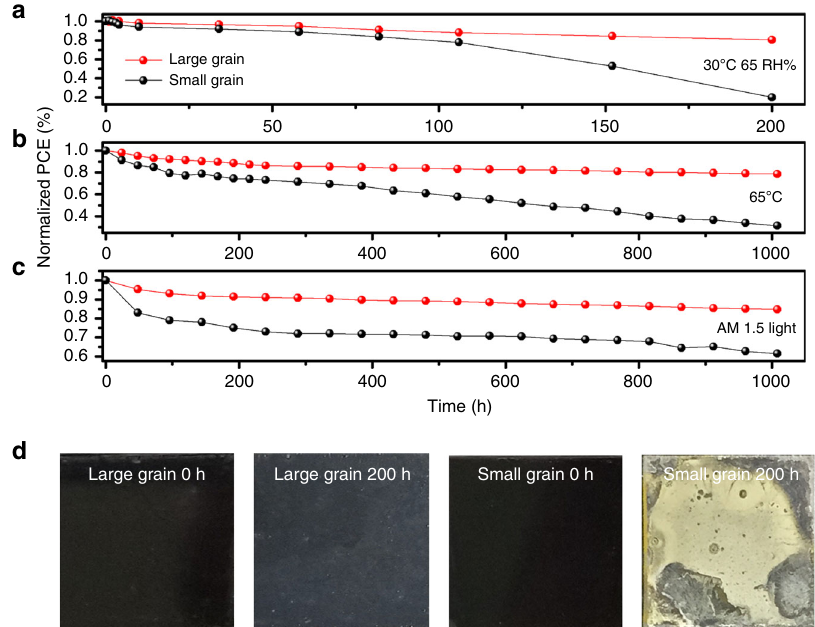
Fig. 5 Stability performance measurements. a – c Stability assessment of non-encapsulated perovskite solar cells with the large-grain and the small-grain perovskite fi lms. Humidity stability at 65 RH% and 30 °C in air ( a ), heat stability at 65 °C in nitrogen environment ( b ), and light stability testing under full- spectrum sunlight at room temperature in nitrogen environment ( c ). d Photographs of the large- and small-grain perovskite fi lms before and after exposure to humidity of 65% for 200 h at room temperature in air (the size of the fi lms is 20 × 20 mm 2